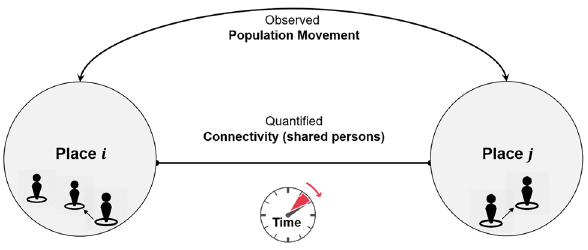
Figure 1. Illustration of place connectivity index based on shared social media